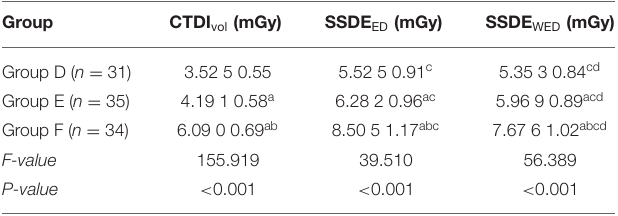
TABLE 4 | Comparison of CTDI vol , SSDE ED and SSDE WED in patients with abdominal CT enhanced scan ( n , ±